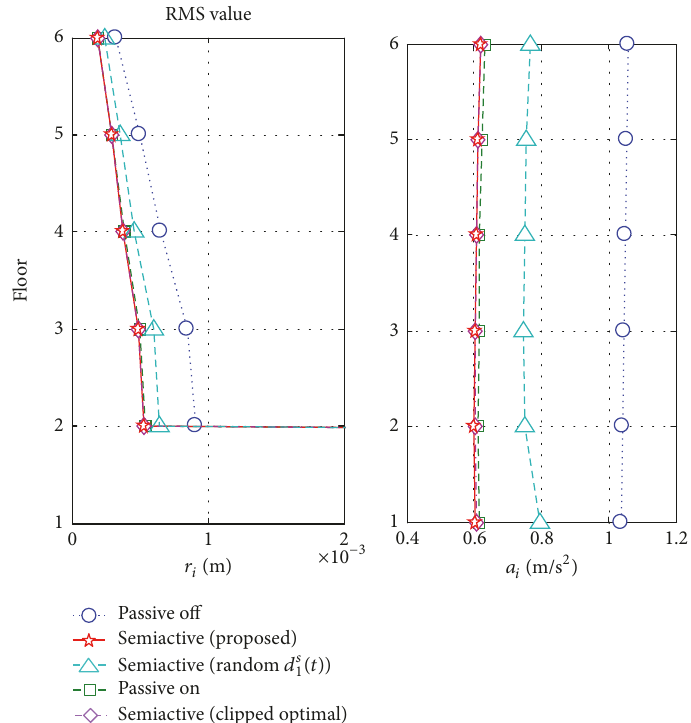
Figure 10: Simulation results for the BCJL1 earthquake disturbance; RMS values of the relative displacement between neighboring floors and absolute acceleration of each floor.